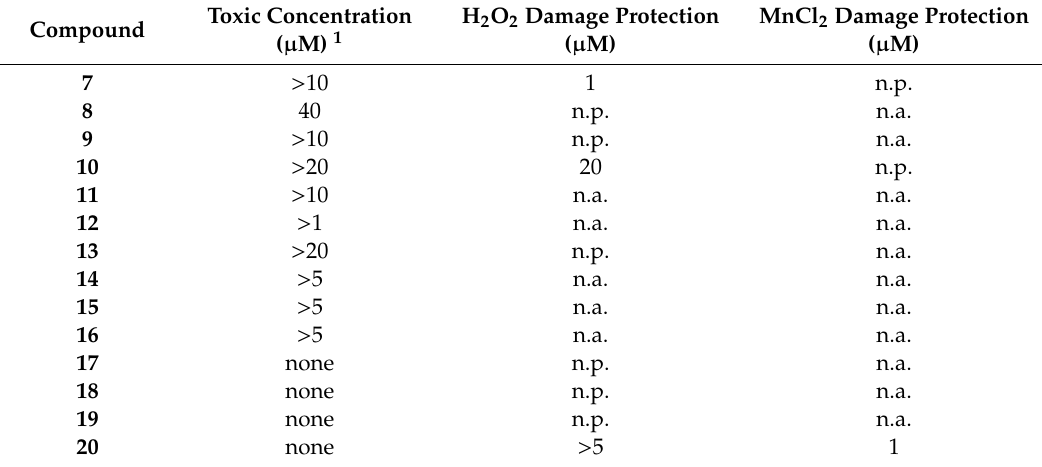
Table 2. Results obtained on PC12 cells following the screening of concentrations (from 1 to 40 µ M) of the compounds under study, the co-treatment with 100 µ M H 2 O 2 and with 1 mM MnCl 2 .